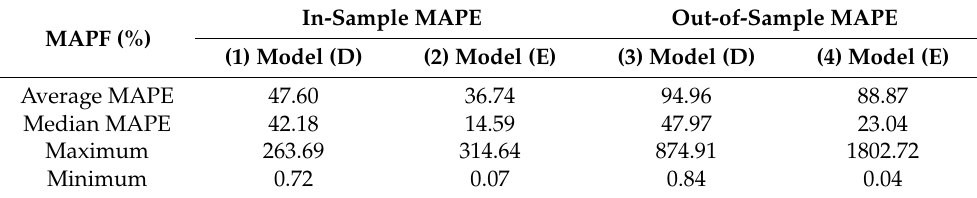
Table 3. MAPE of MRA